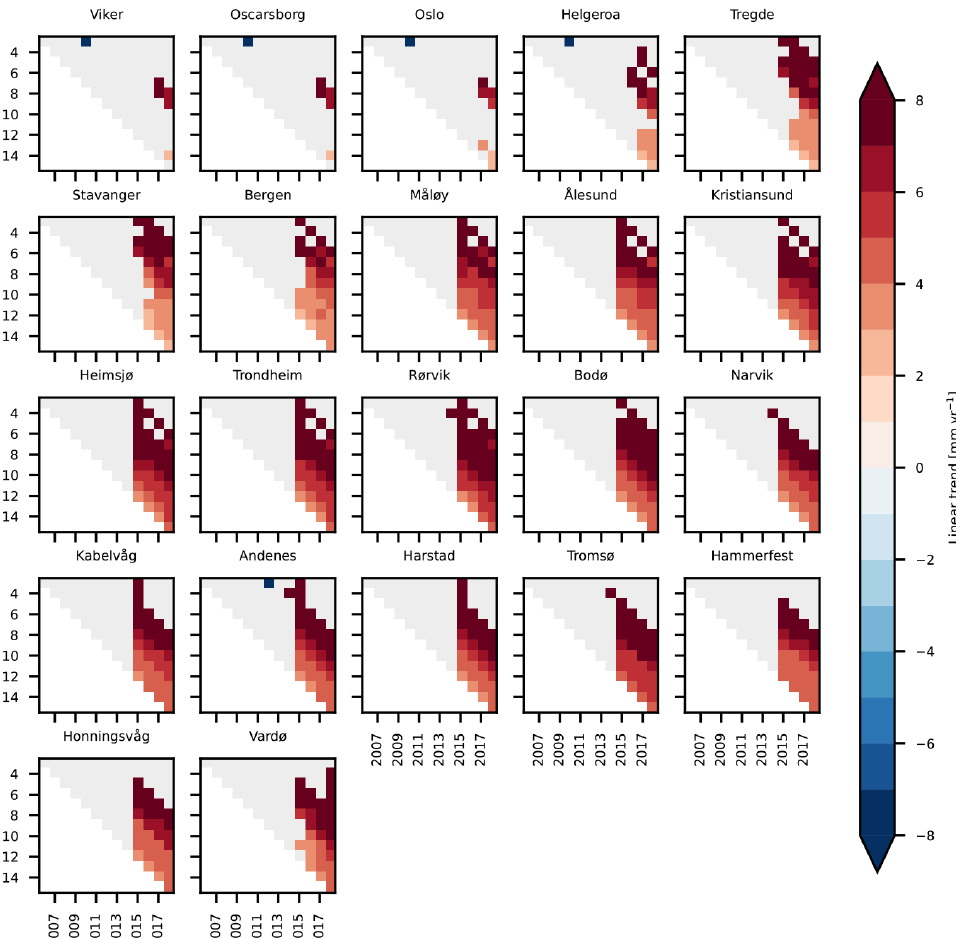
Figure 10. Stability of the sea-level trend along the Norwegian coast. At each tide-gauge location, the linear trend of the SLA from ALES as a function of the period considered. Each panel refers to a tide-gauge location and shows all the possible trends computed up to the year shown on the x axis, considering the number of years displayed on the y axis. For example, the point ( x = 2014, y = 5) in each panel shows the linear trend of the SLA computed over the 5-year period between 1 January 2009 and 31 December 2014. Light gray is used to mask values that are not significantly different from zero at the 0.05 significance